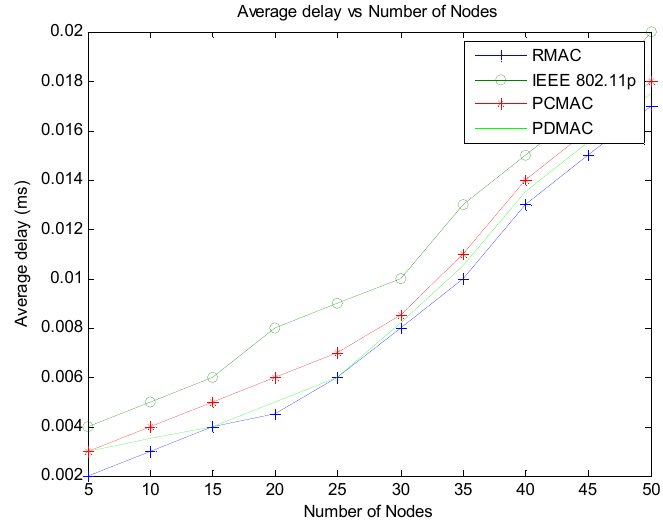
Figure 14. Average delay vs. number of nodes.